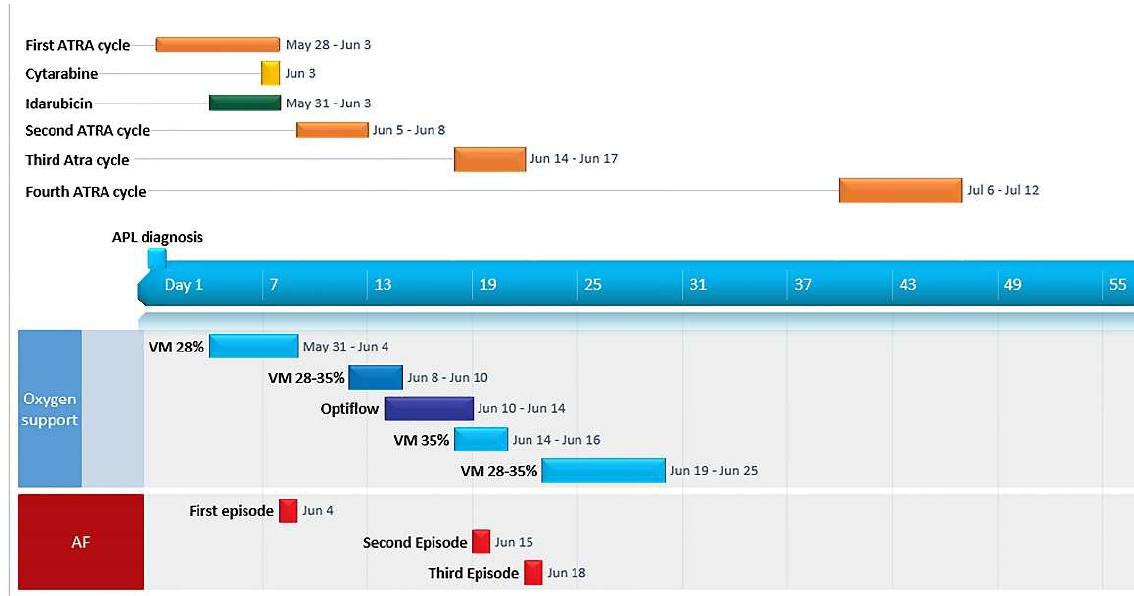
Figure 2. Gantt graph displaying patient’s clinical course during the treatment of acute promyelocytic leukemia (Office Timeline.Version 6.00.06, 2021 Office Timeline Inc., Bellevue WA 98004, USA). AF : atrial fibrillation; ATRA : all trans-retinoid acid; VM : Ventimask.